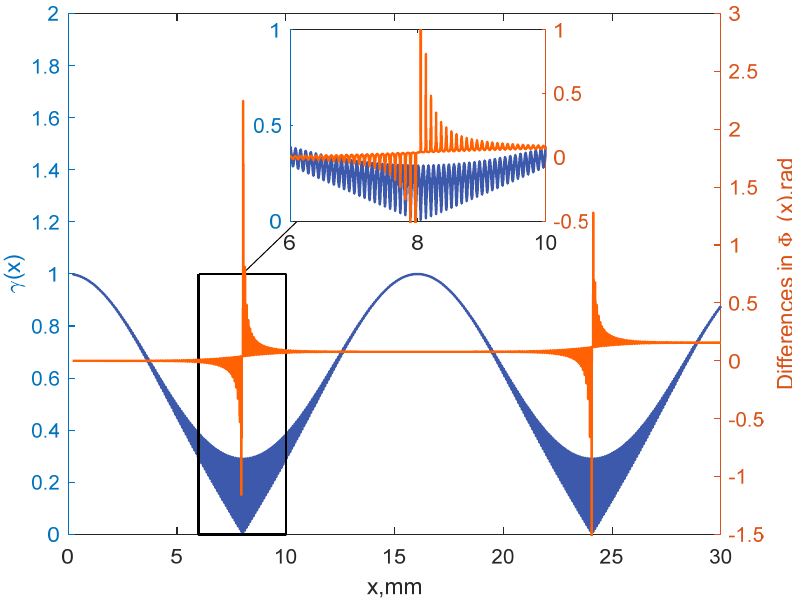
Figure 3. Exposure contrast and difference in φ e ( x ) under the condition δ k = φ g ( X k ). Through numerical calculation and theoretical analysis, the modulation effects of δ k 2. Phase modulation effect by only varying δ k according to X k are as To modulate the phase by only varying δ k , δ k is different at different X k . As shown in Equation (2), the desired phase variation is a quadratic polynomial. More generally, δ k can